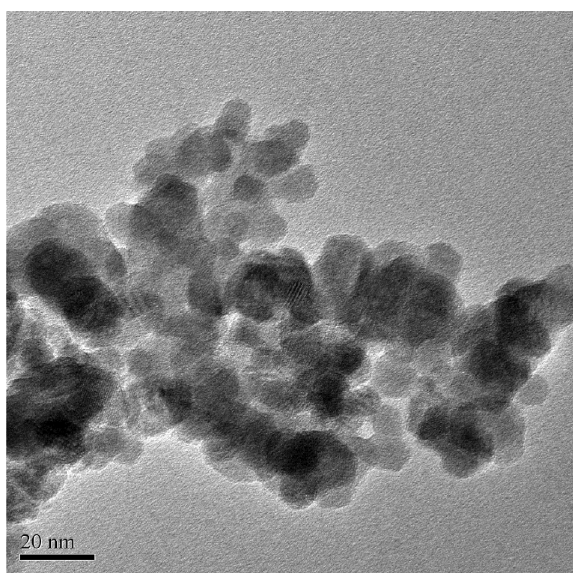
Figure 16: TEM image of sample no.